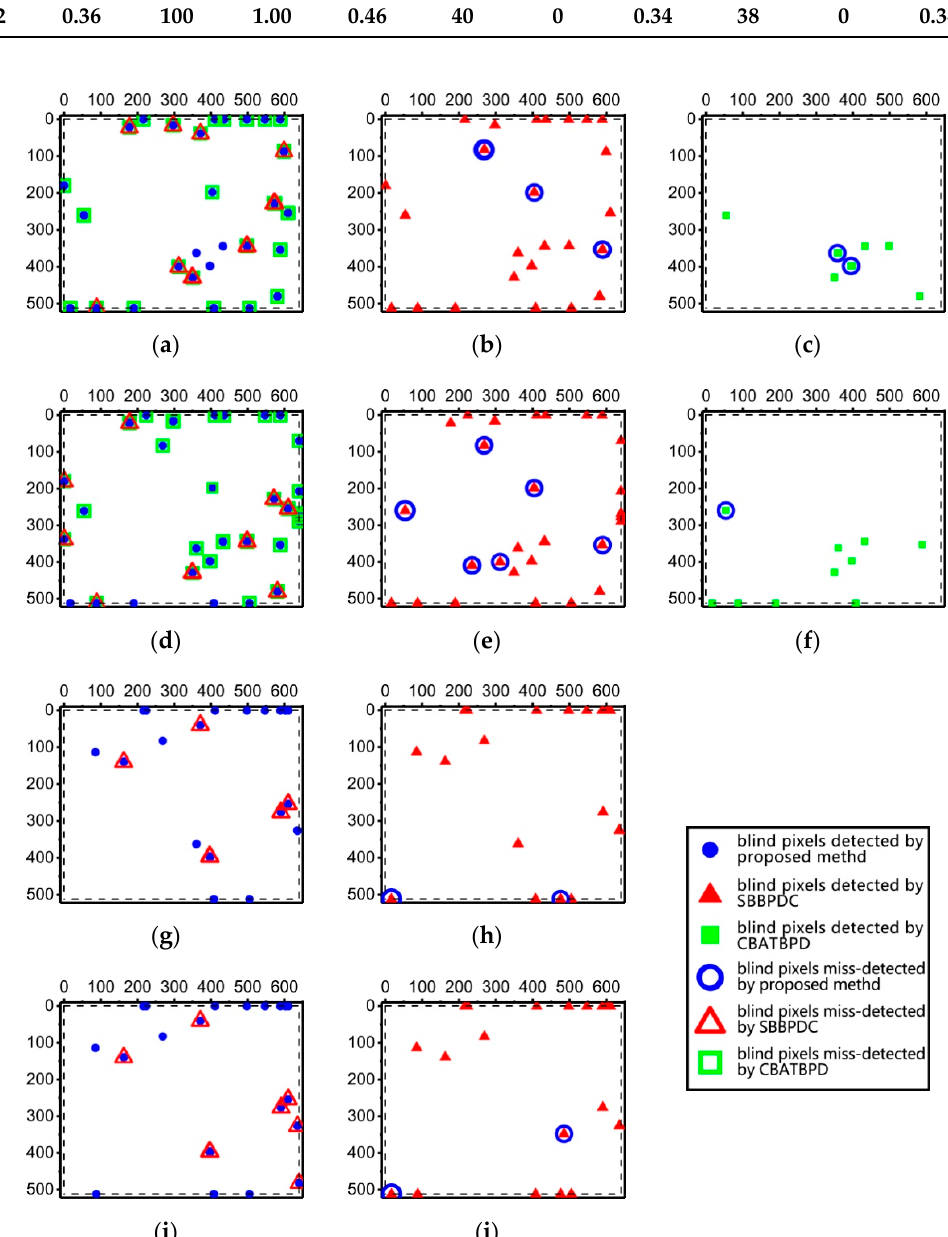
Figure 7. The blind pixel maps of the first sequence of each scenario detected by different